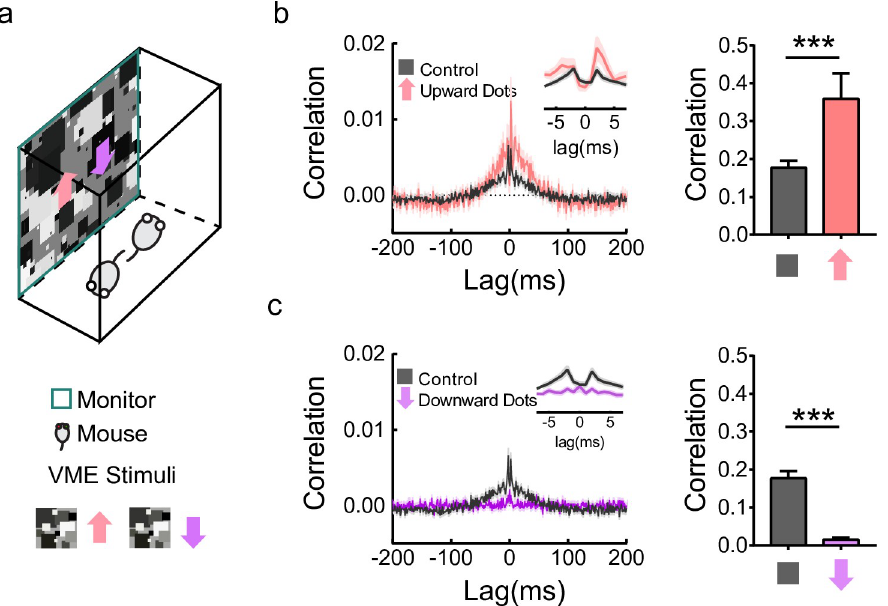
Fig 2. VME affected synchronized activity in V-DSGCs. (a) Diagram of the VME training (top) and the color codes for VME stimuli (bottom). For each stimulus, left, spatial pattern; right, color code with direction of motion. (b) Average cross-correlogram of V-DSGC pairs during travelling gratings stimulus (left) and quantification of correlation strength (right). Control, gray, n = 139 pairs of V-DSGCs; upward VME, pink, n = 51. Shaded areas, ± SEM. Insets are close-up views with 1-ms bin size. For correlation strength comparison, the sum of the spike time cross-correlation (left) from − 100 ms to +100 ms at a bin size of 1 ms are used. ��� p < 0.001, unpaired t test. Error bars, SEM. (c) The same as (b) but to compare the control group with the downward VME group. Control, gray, n = 139; downward VME, purple, n = 130. For correlation strength comparison, ��� p < 0.001, unpaired t test. Error bars, SEM. Data for this figure are in S2 Data. DSGC, direction selective ganglion cell; VME, visual motion experience.